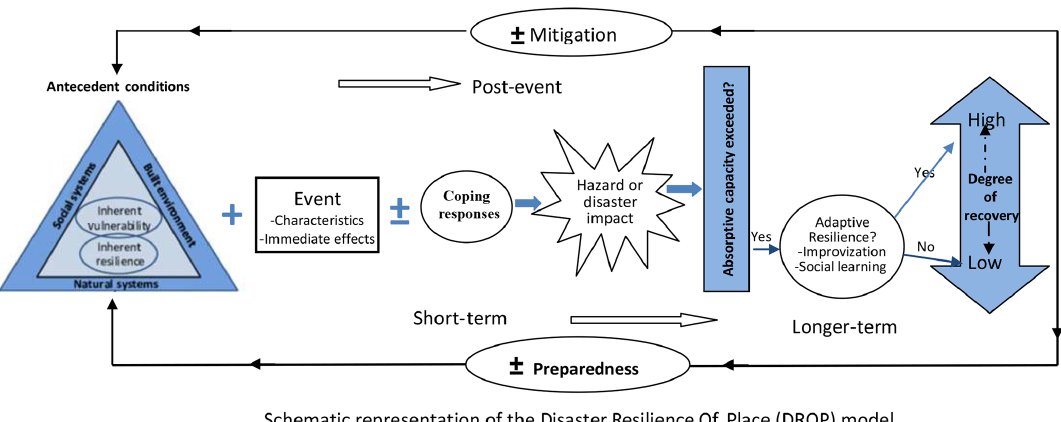
Figure 2. The Disaster Resilience of Place (DROP) model reproduced from Cutter et al. (2008). A place-based model for understanding community resilience to natural disasters. This model illustrates the interrelationship between resilience and recovery within the hazard- resilience